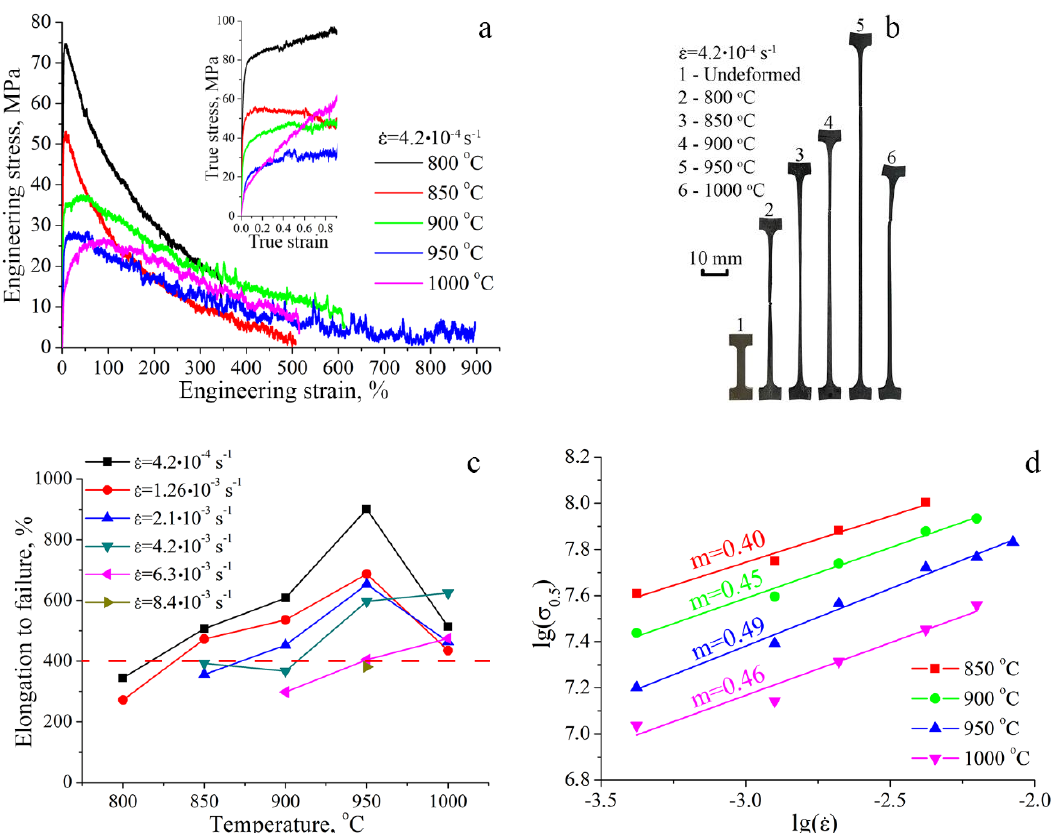
Figure 4. Engineering stress vs. engineering strain diagrams ( a ) and the photographs of the specimens after high-temperature deformation to failure ( b ) at strain rate 4.2 × 10 −4 s −1 . Inset in ( a ) demonstrates true stress vs. true strain diagrams. Elongation of the specimens processed via thermal-mechanical treatment with dependence on test temperature and strain rate ( c ) and strain-rate sensitivity coefficient for different test temperatures ( d ). Table 1. Values of elongation to failure (δ, %) and yield strength (σ 0.2 , MPa) at different temperatures (°C) and strain rates (s −1 ) for V-HNS (high-nitrogen steel) after multistep thermal-mechanical treatment. Strain Rate